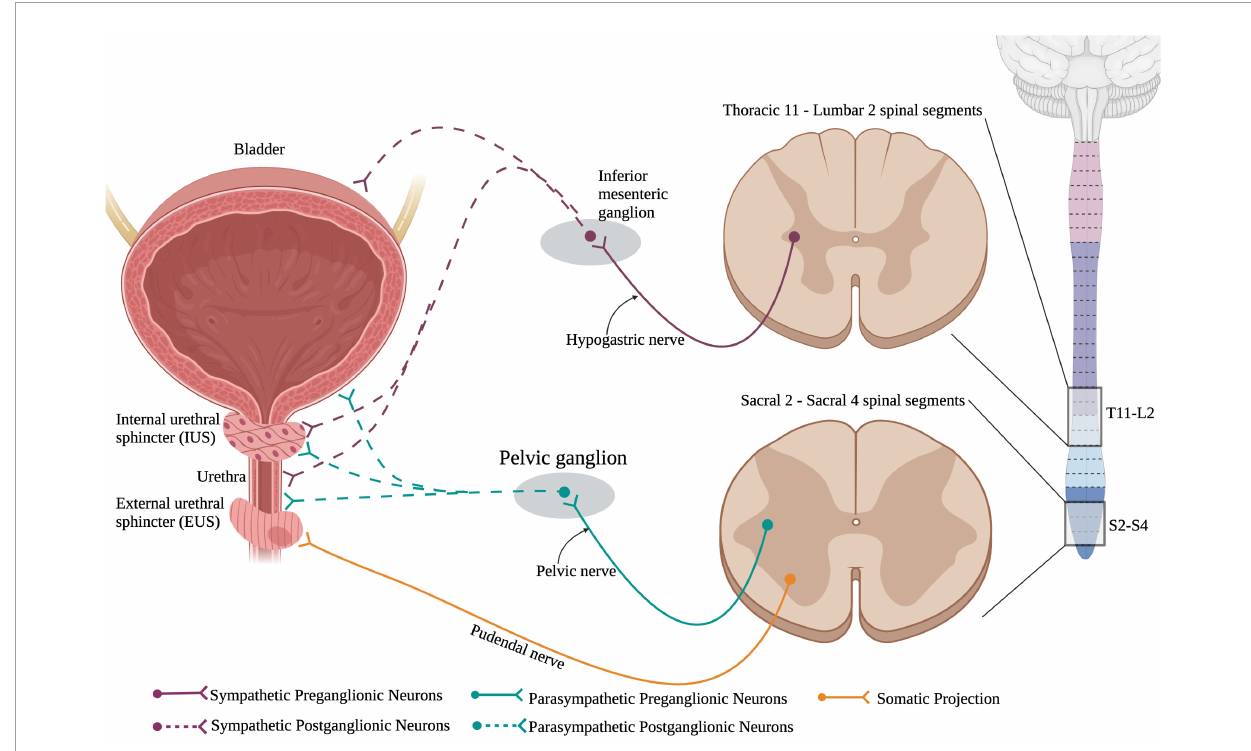
FIGURE6 Neuronal control of the lower urinary tract (LUT). The lower urinary tract receives neuronal control from both branches of the autonomic nervous system and the somatic nervous system. Sympathetic control arises from sympathetic preganglionic neurons in thoracic segments 11 to lumbar segment 2 that extend axons out the hypogastric nerve and synapse onto sympathetic postganglionic neurons within the inferior mesenteric ganglion. These sympathetic postganglionic neurons innervate the bladder, IUS, and urethra. Parasympathetic preganglionic neurons in sacral spinal cord segments 2–4 project axons out of the cord via the pelvic nerve and synapse onto parasympathetic postganglionic neurons within the pelvic ganglion. These postganglionic neurons directly innervate the bladder, IUS, and urethra. Interestingly, the external urethral sphincter is the only muscle in the LUT that is controlled via the somatic nervous system. This allows for voluntary control over urinary functions. (Created using